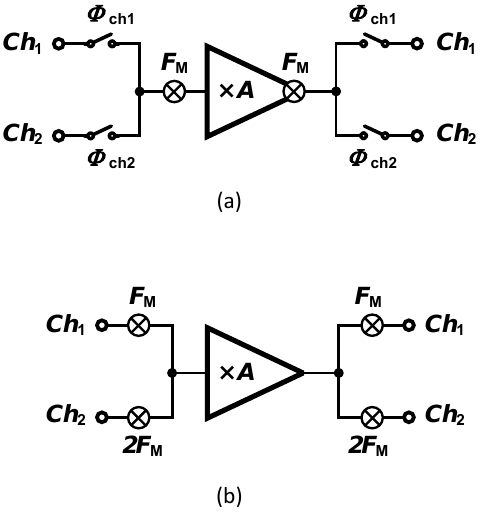
Figure 18. Amplifier sharing techniques: ( a ) time-division multiplexing (TDM) technique proposed in [84] and ( b ) frequency-division multiplexing (FDM) technique proposed in